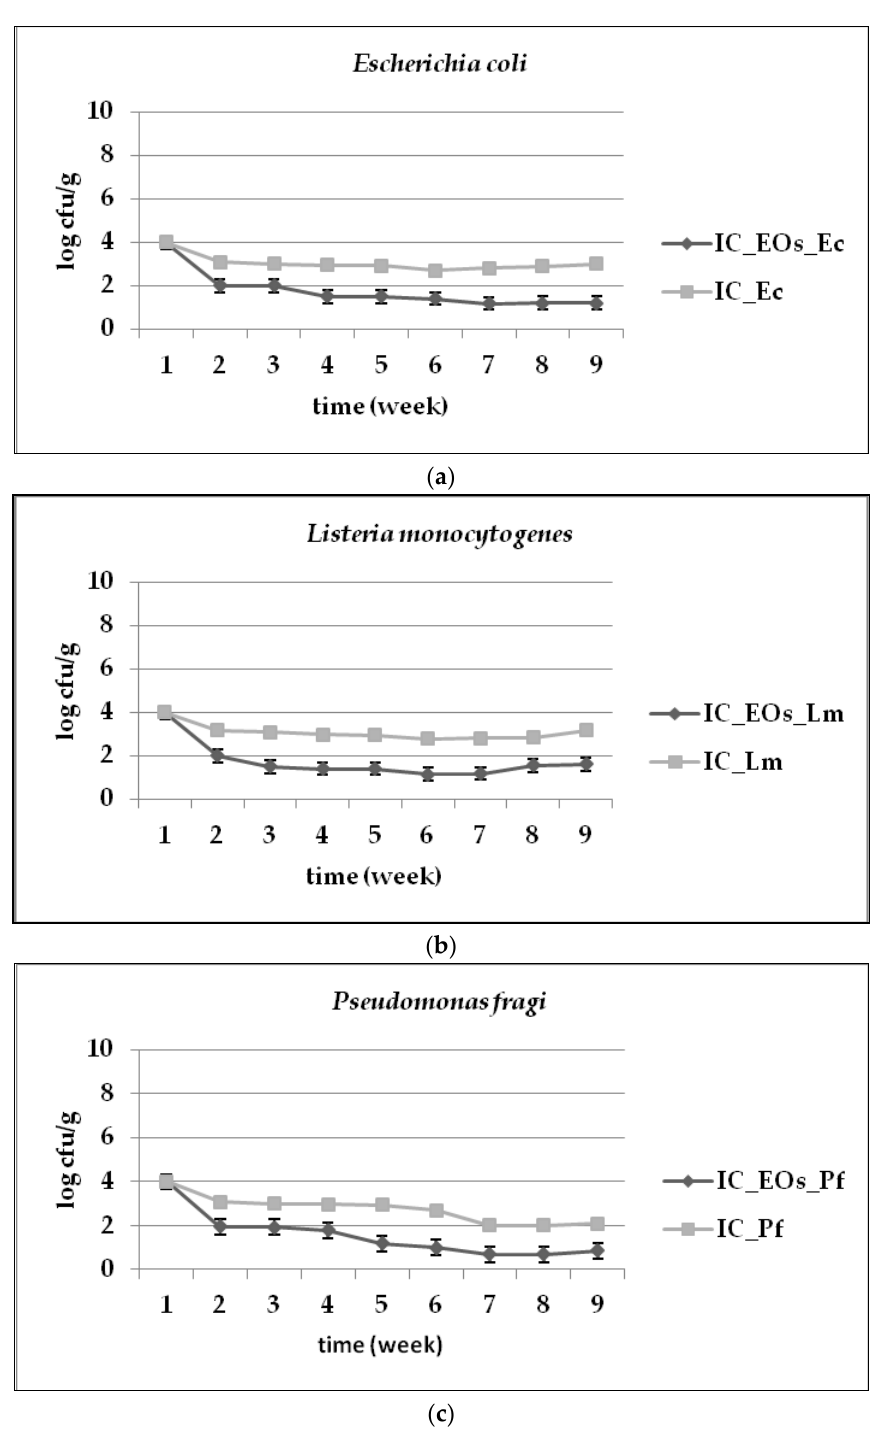
Figure 1. Counts of ( a ) E. coli (Ec), ( b ) L. monocytogenes (Lm) and ( c ) P. fragi (Pf) in spiked samples of ice cream (IC) supplemented with P. lentiscus and F. margarita EOs during storage at − 20 ◦ C. Spiked samples of ice cream with no EOs served as controls.